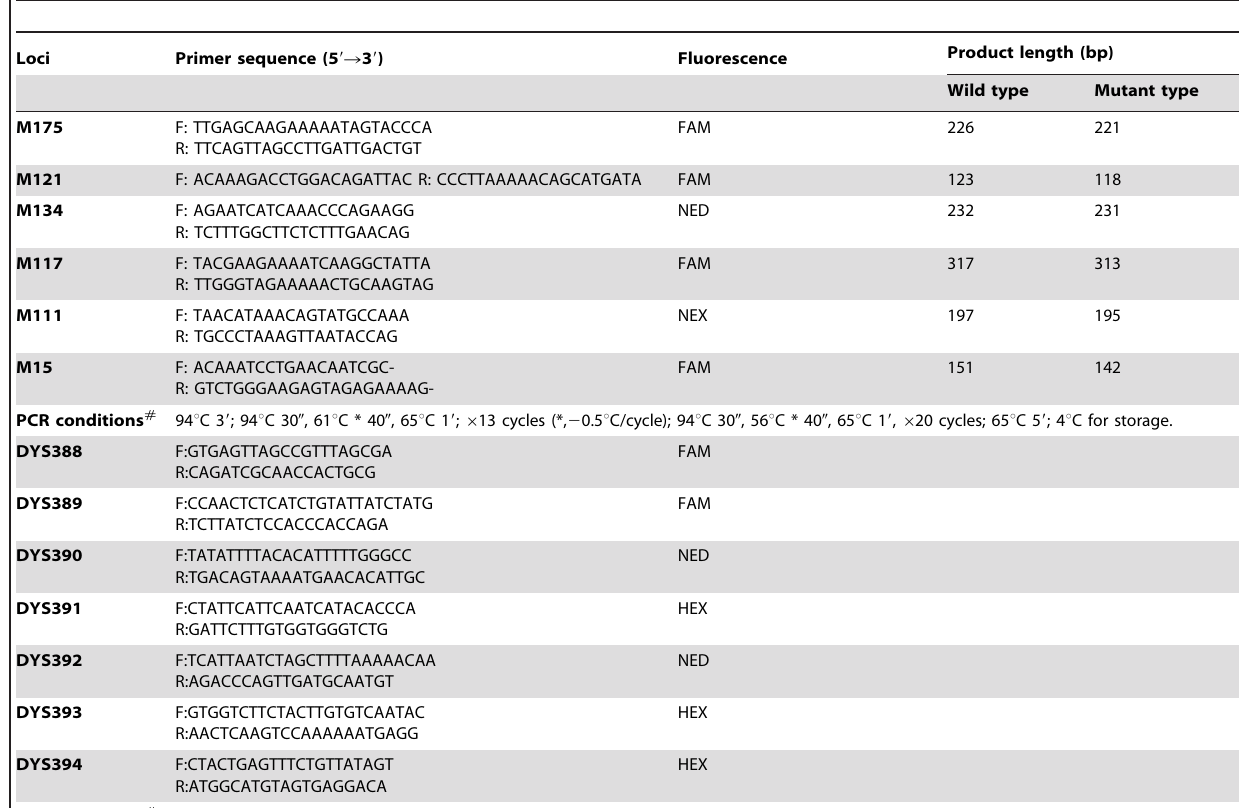
Table 7. Information for six Y-SNP and seven Y-STR fluorescence